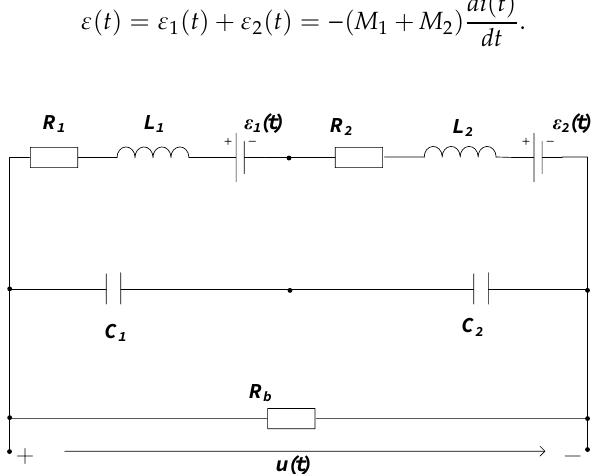
Figure 5. Model 1: Equivalent circuit with a single damper resistance.